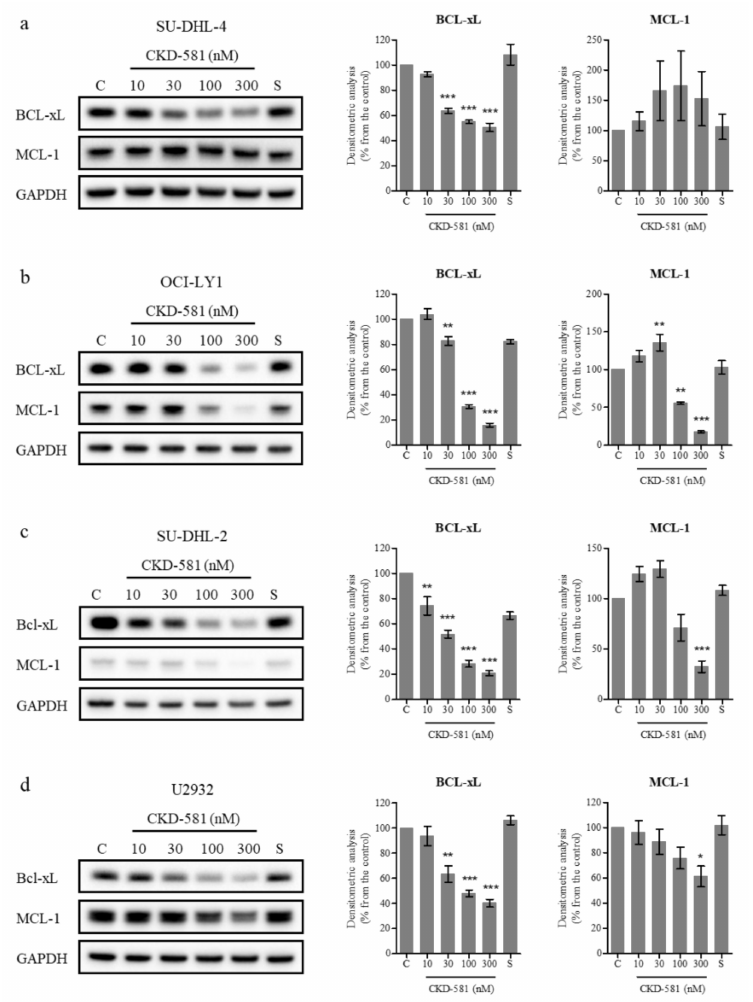
Figure 4. CKD-581 decreases anti-apoptotic proteins in DLBCL. ( a ) SU-DHL-4, ( b ) OCI-LY1, ( c ) SU-DHL-2, and ( d ) U2932 cells were treated with vehicle control (C), CKD-581 (10-300 nM), or 300 nM SAHA (S) for 24 h, and total cell lysates were subjected to immunoblotting for BCL-xL and MCL-1. Data represent mean ± SEM ( n = 3, significant vs. control; * p < 0.05, ** p < 0.01, *** p <